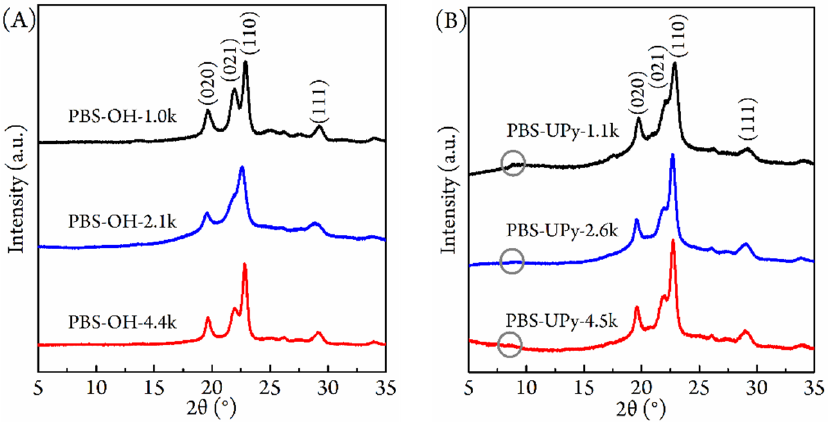
Figure 5. Wide angle X-ray diffractograms of PBS-OH series ( A ) and PBS-UPy series ( B ).